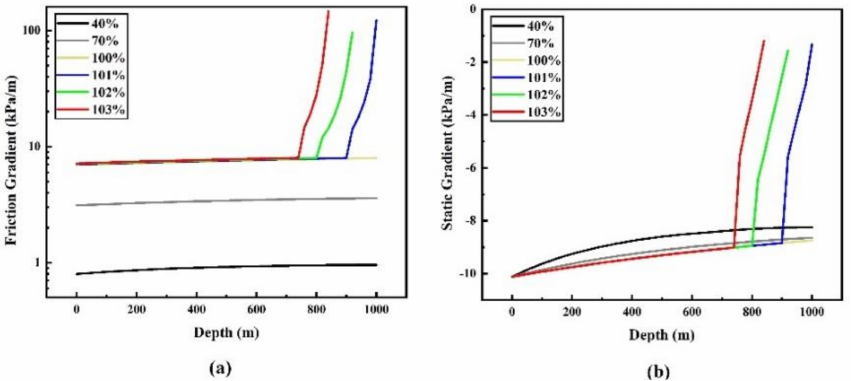
Figure 5. Variation of friction gradient ( a ) and static gradient ( b ) with depth under di ff erent flow rates of 15 mm pipe